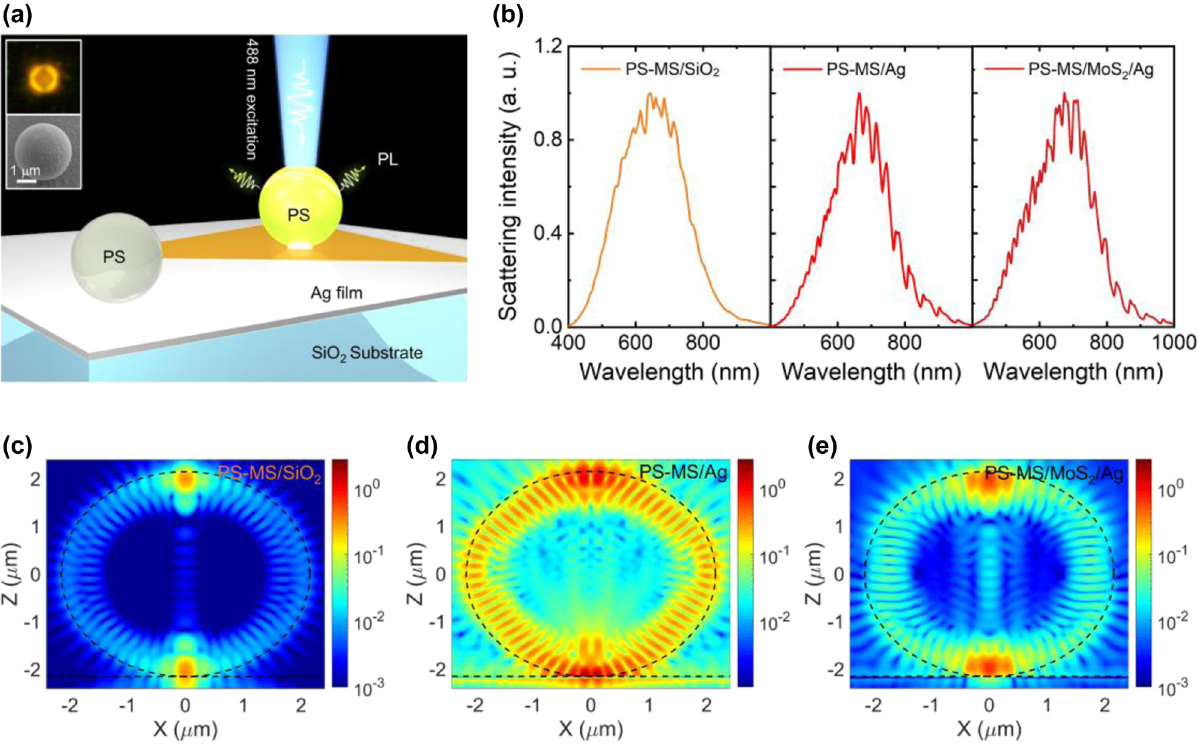
MS placed on different substrates. (a) Schematic showing the characterization of the PL from a Figure 1: WGMs supported by a SiO 2 /Ag microcavity being excited by an external laser light. The dark-field image and SEM image of a typical PS MS are shown in PS-MS/MoS 2 the insets. (b) Backward scattering spectra measured for a PS-MS/SiO microcavity with d ∼ 4.3 μ m. (c)–(e) In-plane electric field intensity distribution ( | E 595.8 nm for the PS-MS/SiO microcavity, the PS-MS/Ag microcavity, and the PS-MS/MoS 2